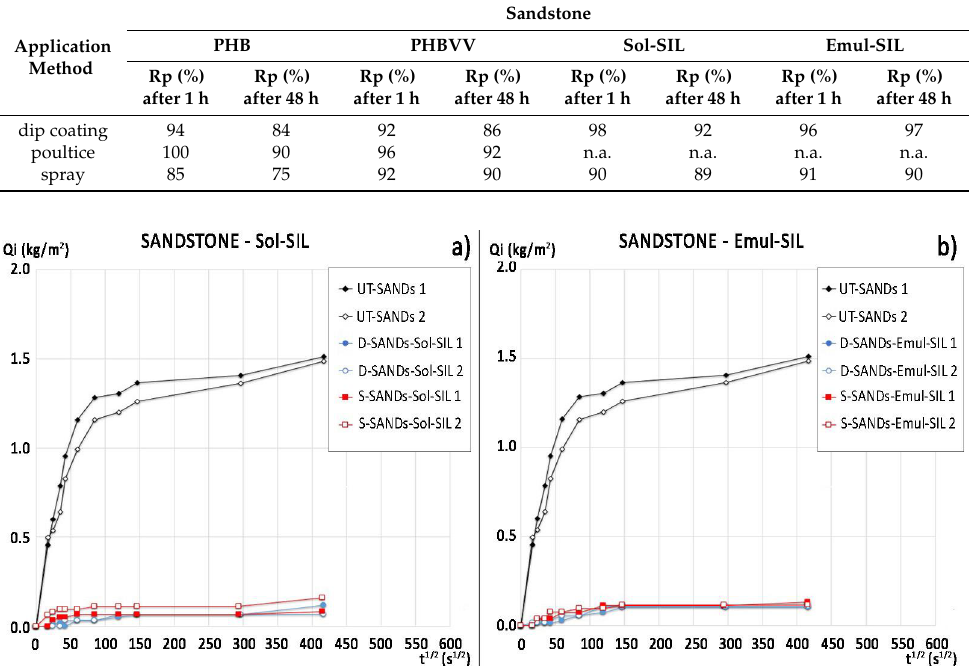
Figure 4. Water absorption curves of sandstone samples treated with: ( a ) Sol-SIL by dip coating and spray and of untreated samples (replicate samples for each condition); ( b ) Emul-SIL by dip coating and spray and of untreated samples (replicate samples for each condition).